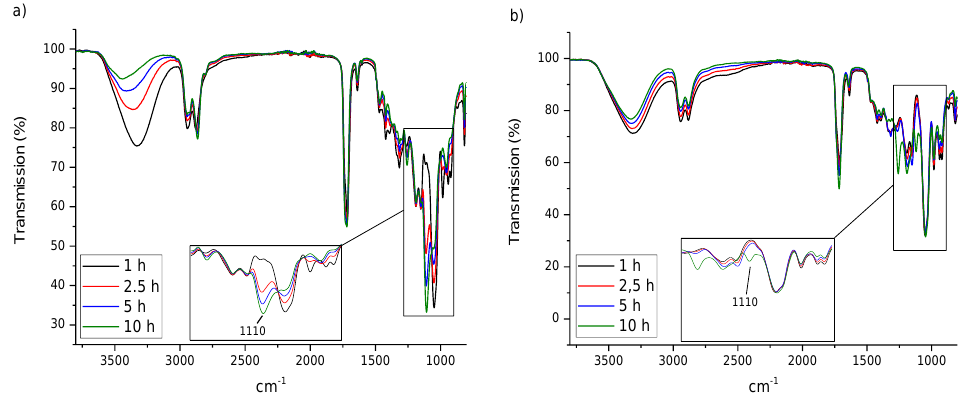
Figure 4. FT-IR spectra of the polycondensation of IA with an excess of PDO in the presence of ( a ) MSA and ( b ) Zn(OAc) 2 .